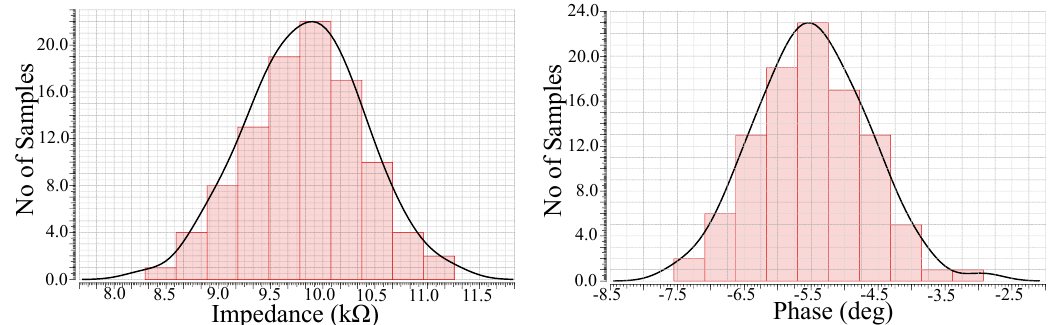
Figure 36. Sensitivity performance of phase for target impedance R b = 10 k Ω using Monte-Carlo analysis (versatile